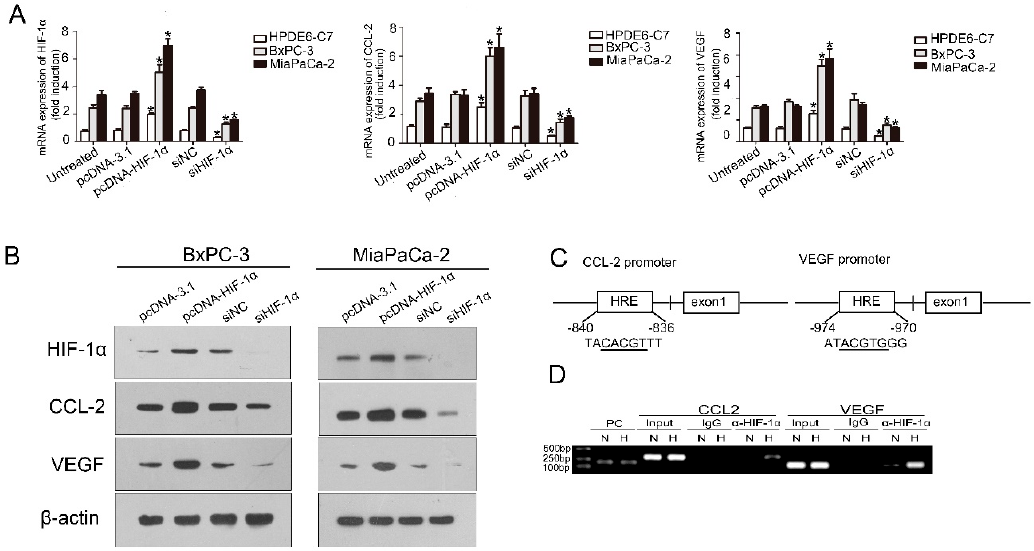
Figure 3. HIF-1 α regulated the expression of CCL2 in PDAC cells, PC, N and H indicate positive control, normoxia, and hypoxia, respectively. ( A ) HPDE6-C7,BxPC3 and MiaPaca-2 cells were transfected with siHIF-1 α (50 nmol/L) and pcDNA3.1-HIF-1 α plasmids (4 µg) for 48 h, respectively; the mRNA expression levels of HIF-1 α and CCL2 were assessed by qRT-PCR. The experiments were performed thrice independently. * p < 0.05 vs. control. Cells without treatment and normal pancreatic cell with transfection treatment were adopted as two negative controls. Vascular endothelial growth factor (VEGF) was used as positive control; ( B ) Western blot analysis confirmed the protein level expression correlation between HIF-1 α and CCL2 in PDAC cell lines. The experiments were performed thrice independently. VEGF was used as positive control; ( C ) The DNA sequence of the CCL2 promoter ( left ) and the DNA sequence of the VEGF promoter ( right ); ( D ) Chromatin immunoprecipitation analysis in MiaPaCa-2 cells. The PCR products of VEGF promoter were used as positive control. PC, N and H indicate positive control, normoxia, and hypoxia, respectively.